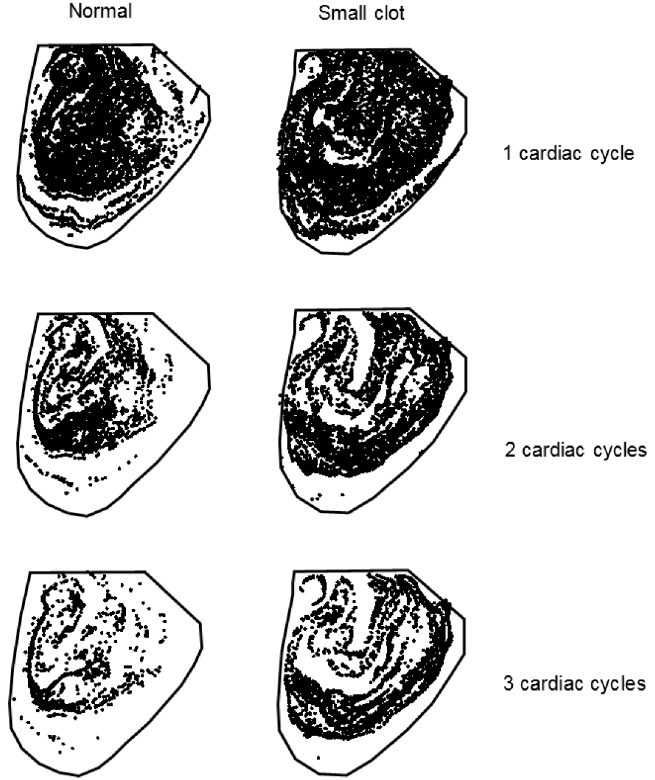
Figure 6. Particle transport for the DCM model ( left ) and the LVOT thrombus model ( right ) after 1, 2 and 3 cardiac cycles.